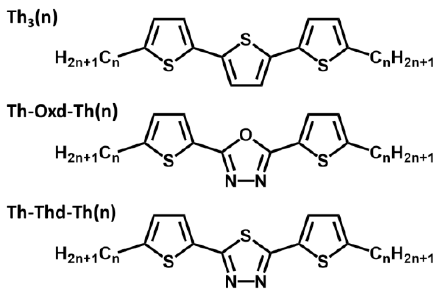
Figure 1. The structures of compounds Th3(n) , Th-Oxd(n) and Th-Thd-Th(n) .